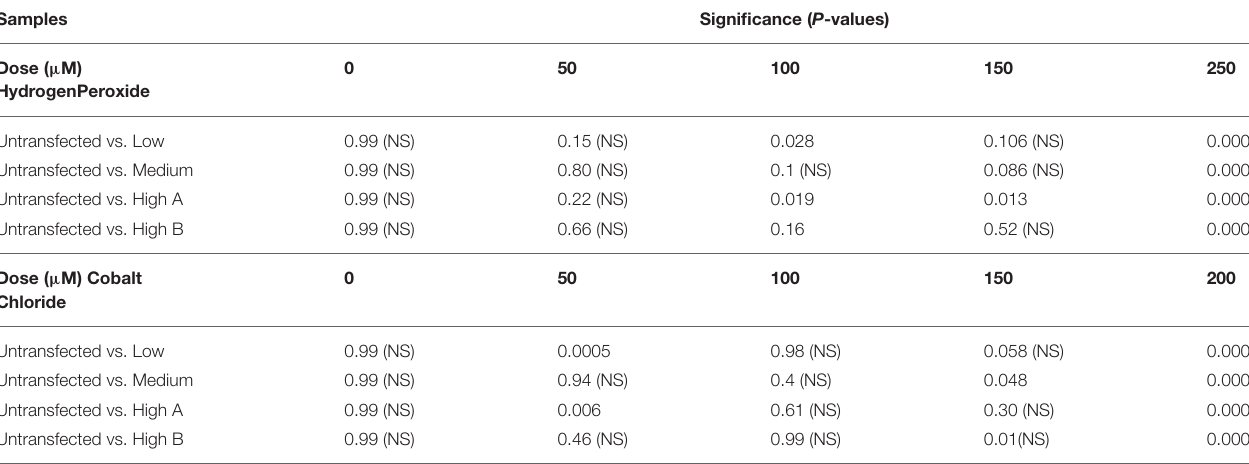
TABLE 3 | Effect of FtMt overexpression on resistance to oxidative stress by hydrogen peroxide and cobalt chloride.